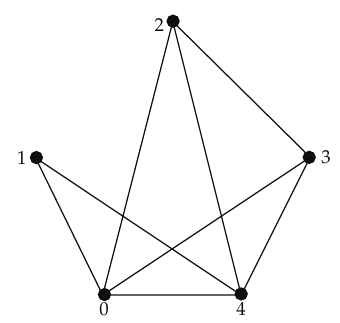
Figure 3: Associated graph Γ(cid:2) X (cid:3) of X .